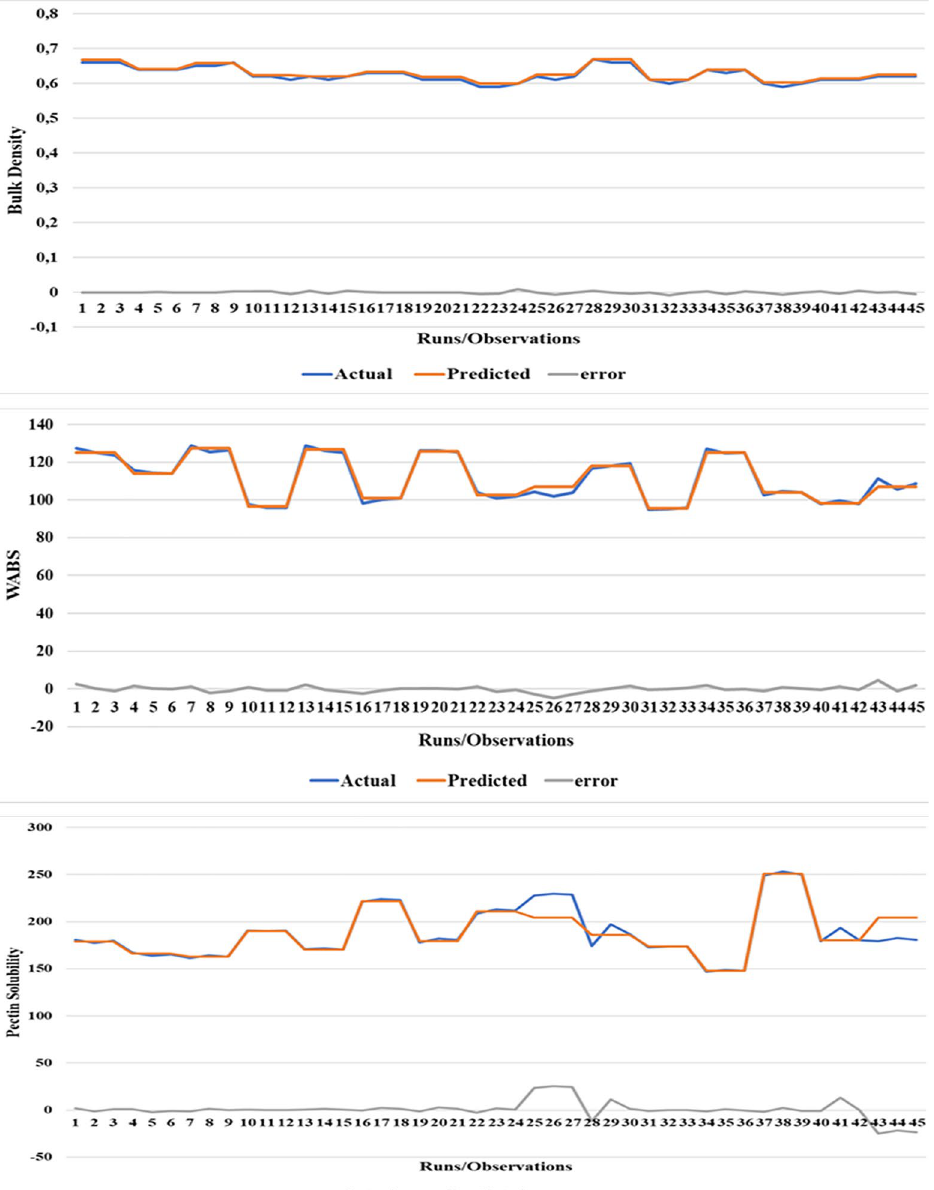
Figure 5. Predicted, actual response, and error for the cooking characteristics studied.